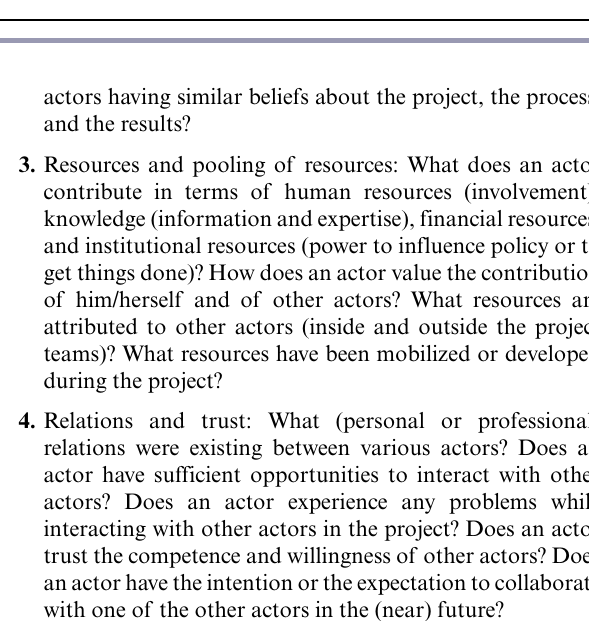
Table 1 . Overview of missions by Dutch actors to Romania and (study) visits by Romanian actors to the Netherlands. Activity Period Scope, participants, and activities of various missions and visits Mission 1 Oct 2009 Dutch team visits Tecuci to discuss the project content and organization in plenary and small-scale meetings and to visit the project area; two Dutch actors visit the water company and county council of Gala ţ i Visit 1 Dec 2009 Romanian team visits Groningen area to further define the process in plenary meetings and interactive workshops and to visit the region Mission 2 Jun 2010 Dutch team visits Tecuci to discuss the project progress and goals with the Romanian team in plenary meetings and workshops Mission 3 Three Dutch actors visit a Dutch-Romanian workshop on flood risk management in Gala ţ i Mission 4 Visit